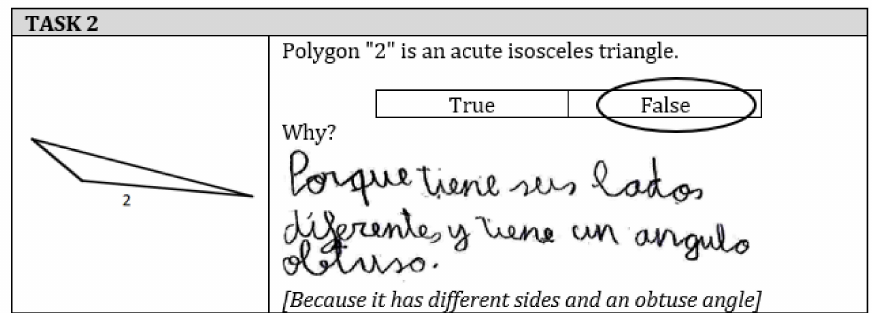
Figure 15. The answer given by student G2S27 when performing the task of recognizing and reasoning about the triangle’s